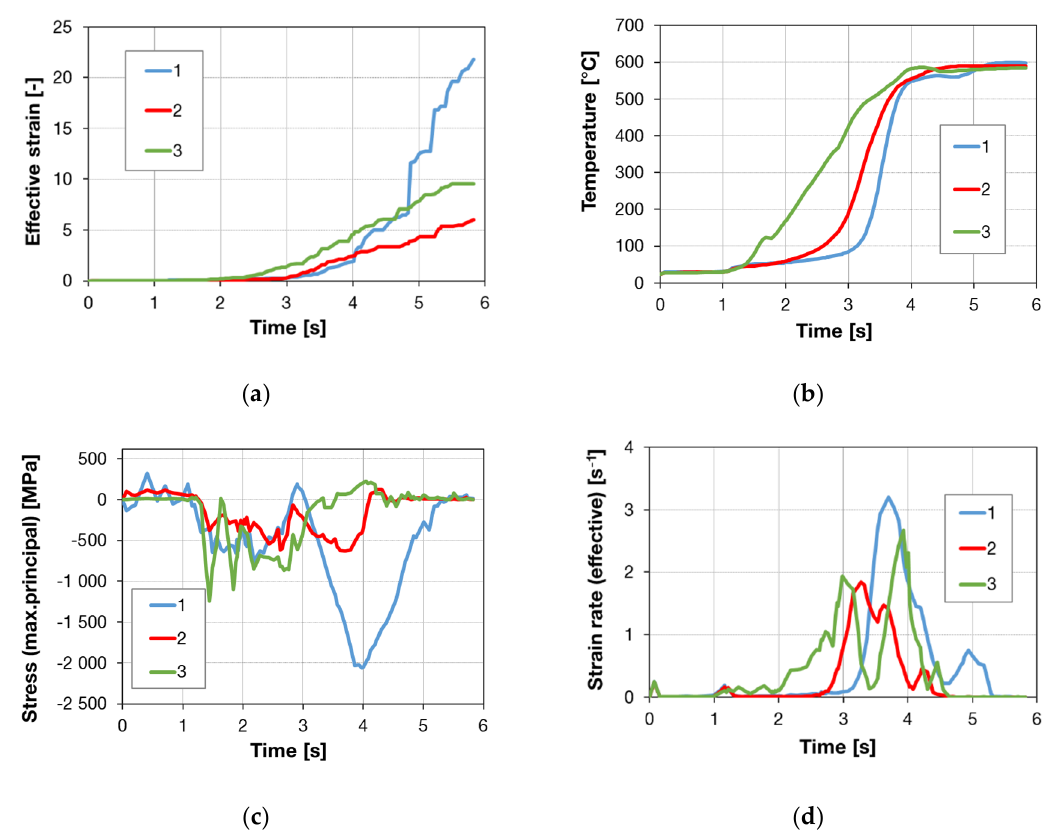
Figure 7. Process parameters in dependence on time: ( a ) effective strain, ( b ) temperature, ( c ) maximum stress and ( d ) strain rate.